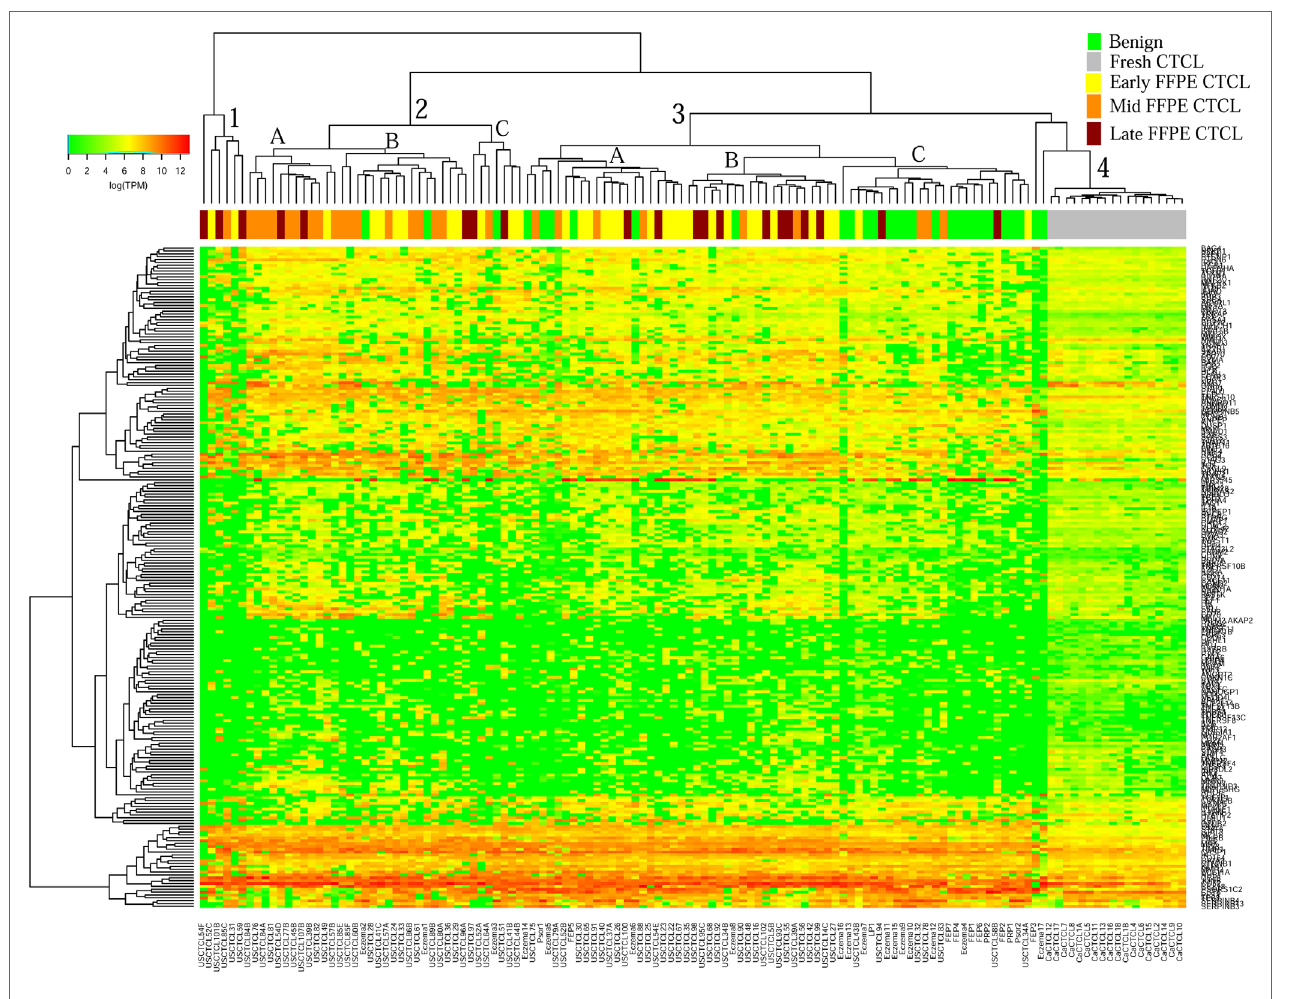
FigUre 2 | Unsupervised hierarchical clustering analysis based on TruSeq targeted RNA gene expression analysis of 284 select genes in benign inflammatory dermatoses (green), freshly obtained and snap-frozen cutaneous T-cell lymphoma (CTCL) samples (gray), and ≥ 2009 formalin-fixed paraffin-embedded (FFPE) CTCL samples (early stage, yellow; mid stage, orange; and late stage, dark red). A color key refers to gene expression in log(transcripts per